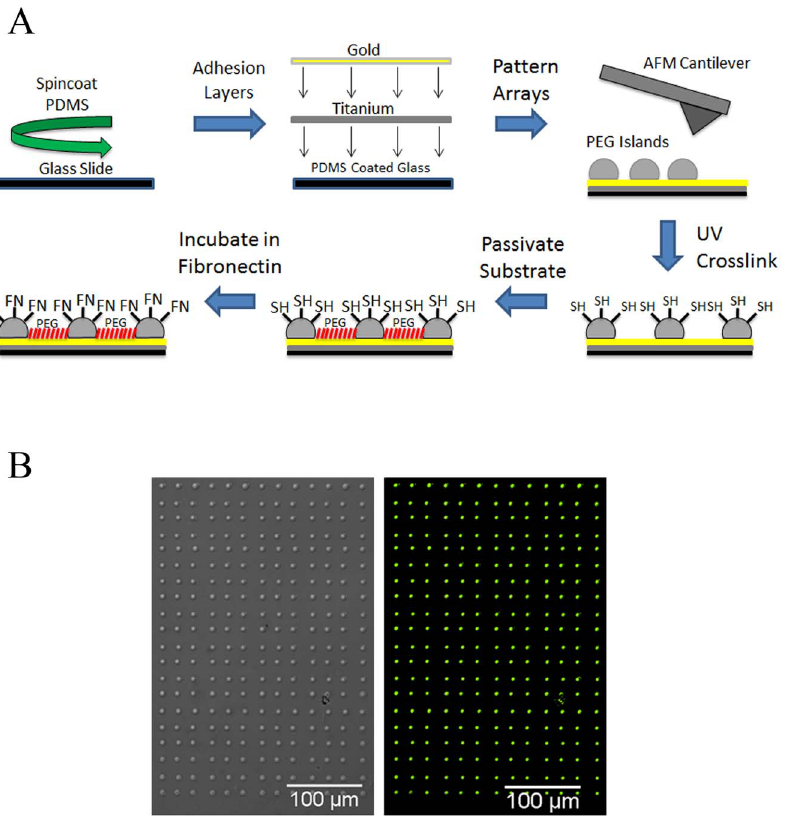
Figure 1. DPN enables micropatterning of sub-cellular hydrogel substrates. (A) PDMS was spincoated onto glass slides to form a background of varying elasticity while utilizing DPN to deposit micropatterned hydrogel islands also with varying elasticity. These sub-cellular islands were functionalized with fibronectin at differing ligand densities, which facilitated cell attachment to substrate. (B) Micropatterned PEG hydrogel islands spaced at 12 m m distance between islands showing 100 m g ml 2 1 BSA-FITC conjugated protein covalently bonded.